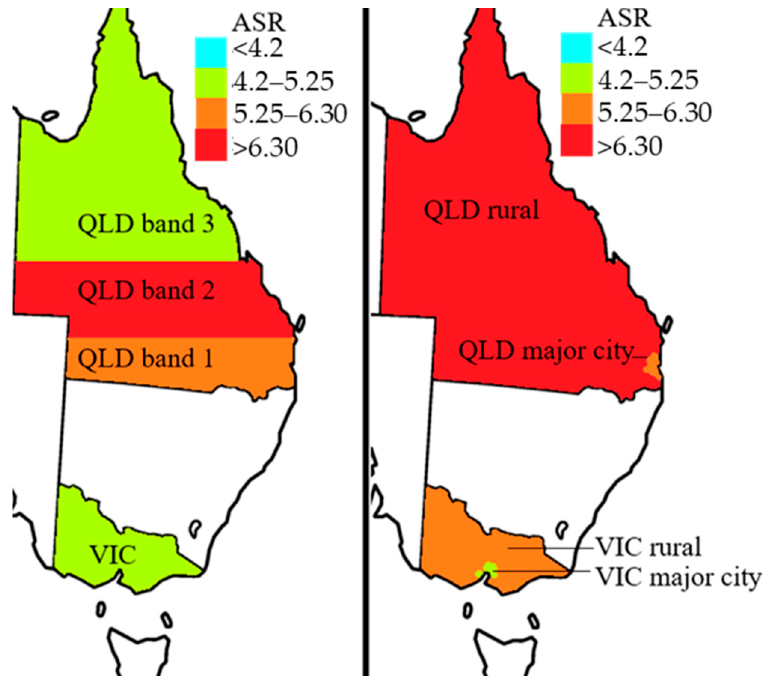
Figure 1. Summary of ASRs in different populations of QLD and VIC from 2001 to 2013. ASR, age-adjusted incidence rates per 1,000,000 person-years, standardized to world standard population.